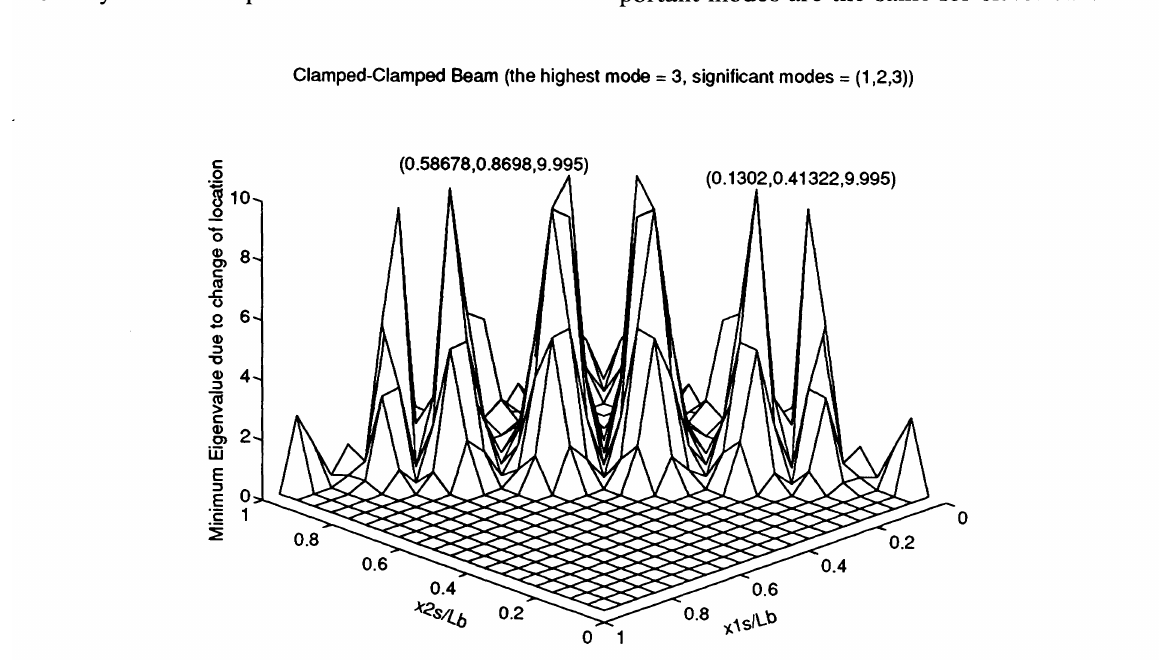
FIGURE 13 Minimum eigenvalue of W~ in clamped-clamped